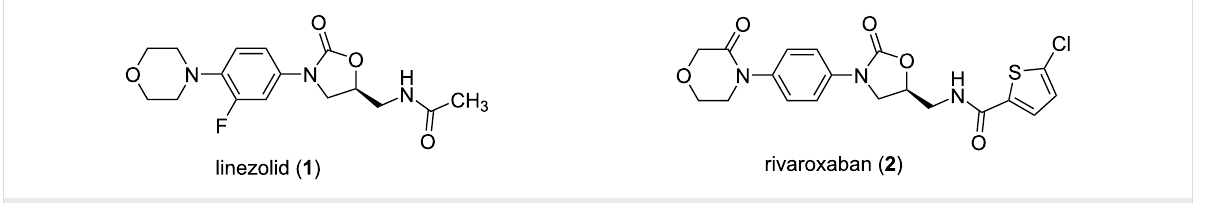
Figure 1: The structure of the oxazolidine-2-one-containing drugs linezolid ( 1 ) and rivaroxaban ( 2 ).